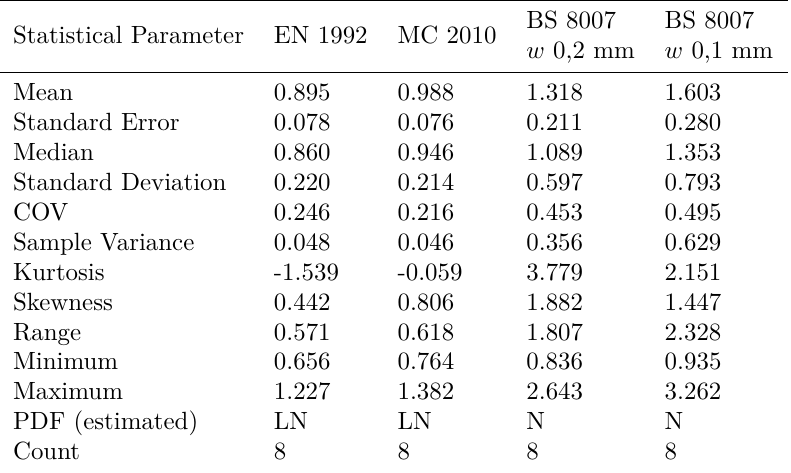
Table 3. Model uncertainty statistical parameters for long-term tension cracking